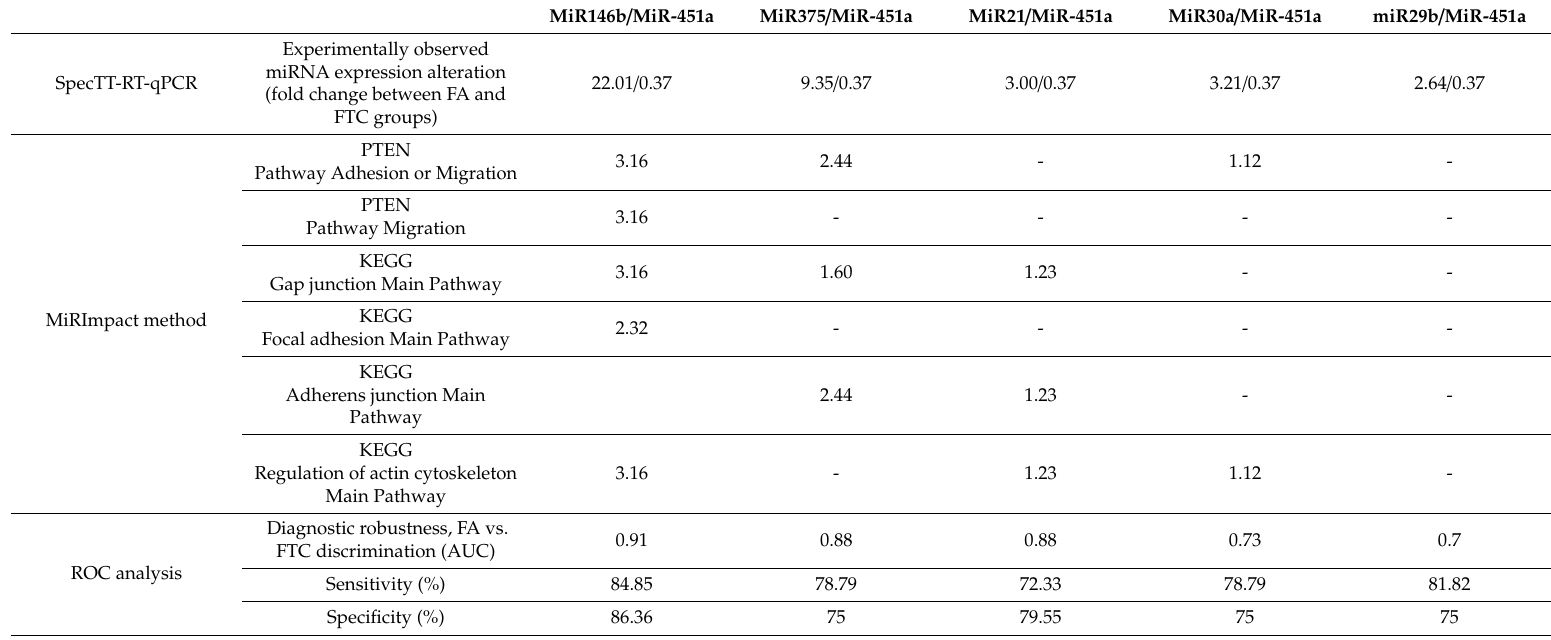
Table 3. MicroRNA-pathway activation strength (miPAS) values reflecting the impacts of microRNA concentrations on the activation of molecular